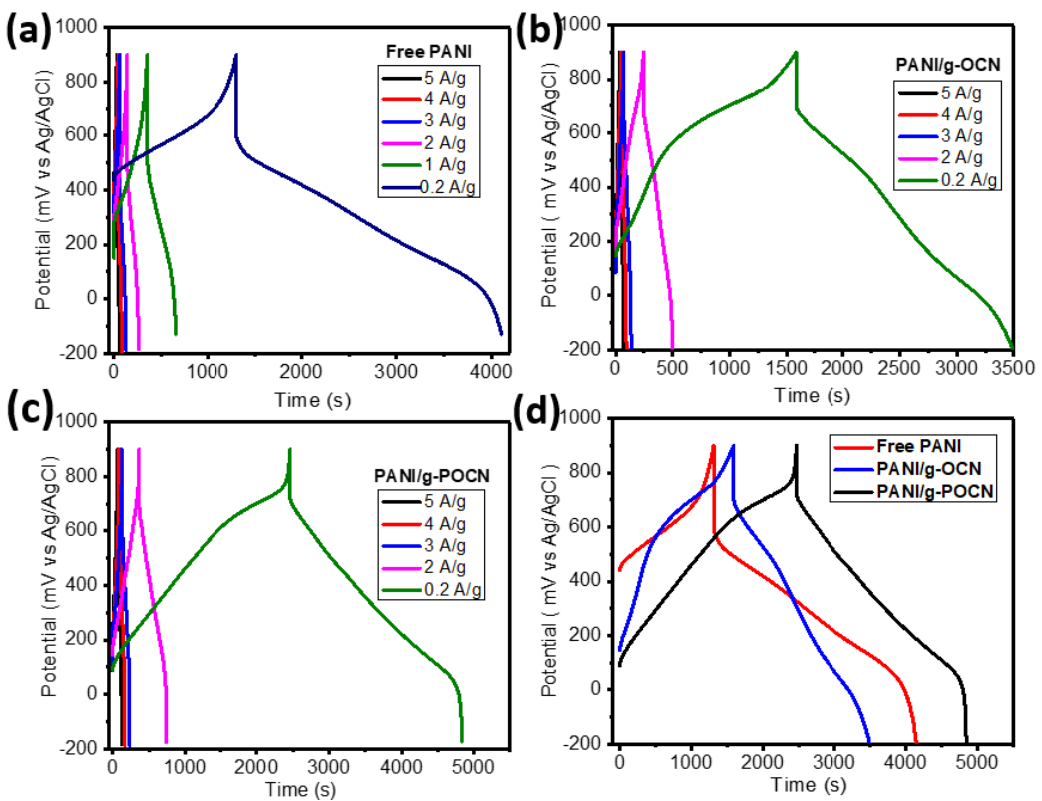
Figure 9. Galvanostatic charge-discharge curves: ( a ) Free PANI, ( b ) PANI/g-OCN, ( c ) PANI/g-POCN, and ( d ) comparison between composites at 0.2 A/g.